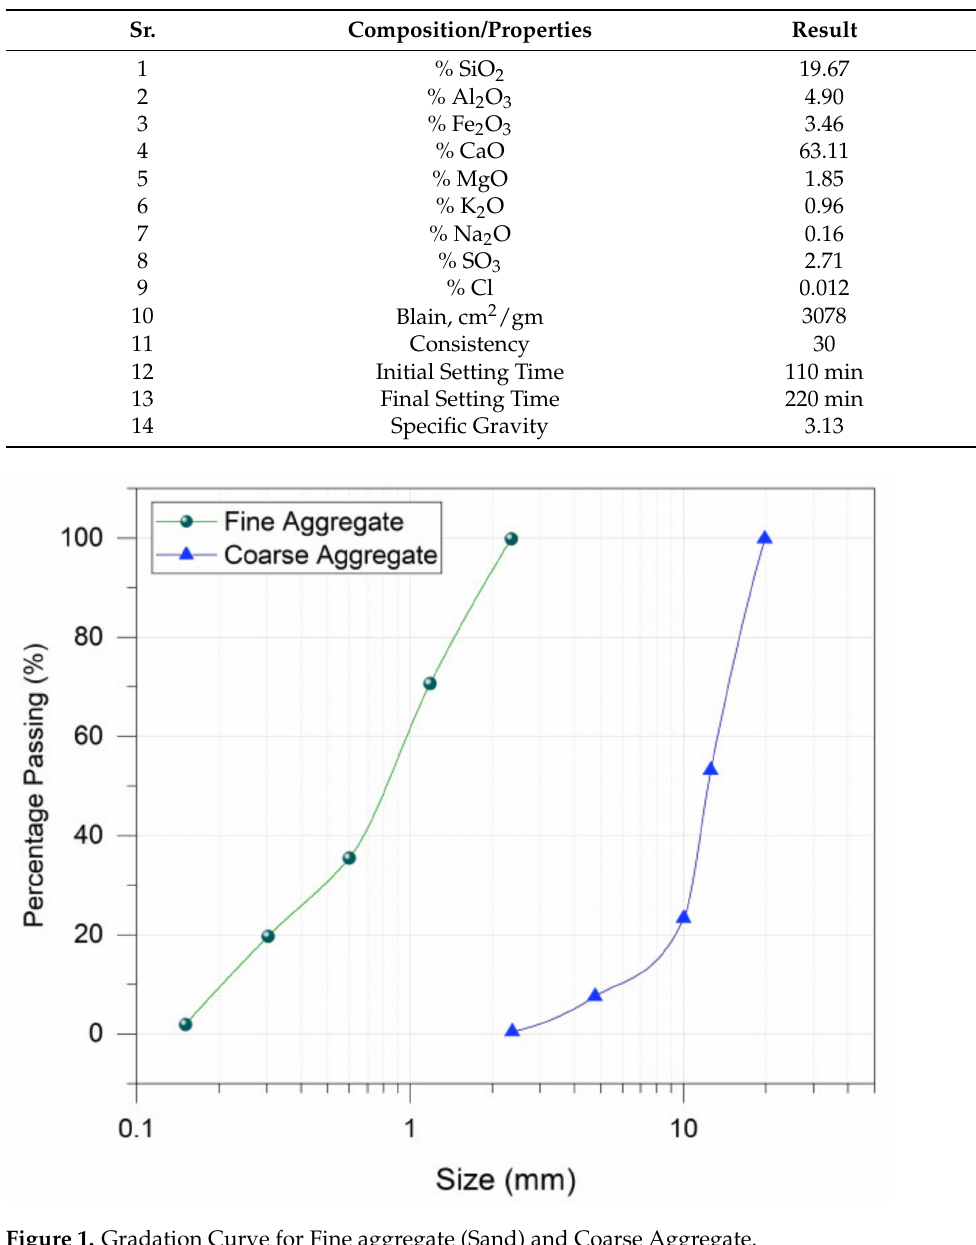
Table 1. Chemical composition and properties of cement.